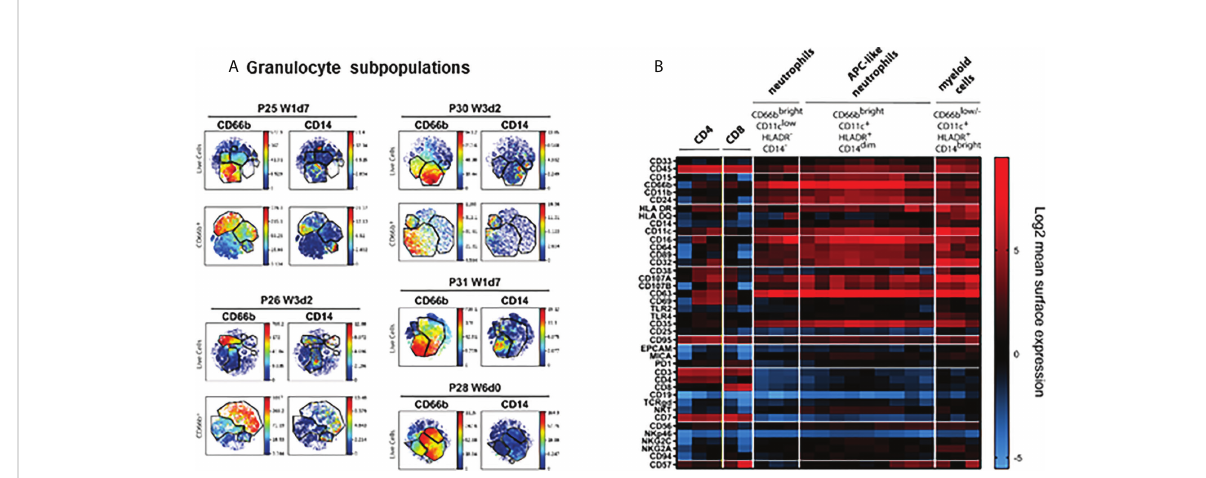
FIGURE 4 Mass cytometry analysis of cells from patients at the same stage of treatment. viSNE analysis was performed grouping all the samples analysed from each patient during the fi rst cycles of BCG treatment. (A) viSNE analysis of granulocyte populations. Granulocyte populations included several subpopulations that expressed distinct surface markers. For a better visualisation of these subpopulation, viSNE was performed gating on CD66b (bottom rows). (B) Heat map. To aid visualisation, the combinations of markers de fi ning the major populations of leukocytes observed in urine of different patients were plotted. This plot allows to identify the different markers expressed in the different populations identi fi ed. The fi gure represents several samples obtained from different